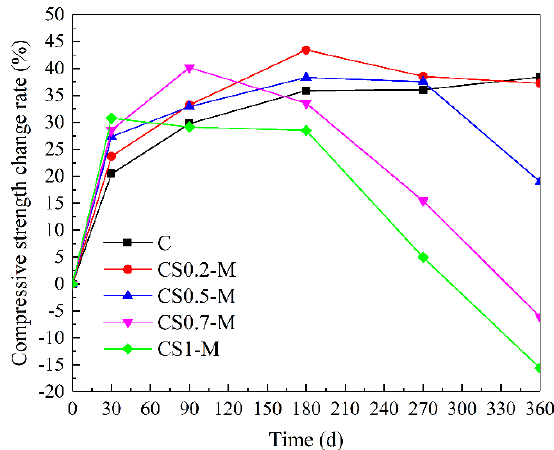
Figure 3. Compressive strength of concrete specimens against corrosion time. The change in damage appearance after erosion for 180 and 360 d from compressive strength tests of samples showed that the damage degree in solutions containing MgSO 4 was significantly higher than for samples in only NaCl solution (Figure 4). After 180 d of erosion, with increased MgSO 4 concentration, cracks on sample surfaces gradually widened and extended, shifting to the middle of samples. CS0.7-M had cracks that ran through each other and concurrent surface peeling. The mortar layer on the surface of CS1-M was severely peeled off and after 360 d of erosion, CS0.2-M showed severe peeling with intersecting cracks that penetrated each other. There are many vertical cracks on the surface of CS0.5-M and CS0.7-M, which exposed a large amount of coarse aggregate. The mortar layer on the surface of CS1-M was also severely peeled off, which showed that in NaCl-MgSO 4 solution, the damage degree in the appearance and morphology of concrete after compressive strength testing increased with increased MgSO 4 concentration and pro- longed erosion time. ( b ) Figure 4. Compressive strength destruction appearance; erosion for ( a ) 180 d and ( b ) 360 d. From the above analytical results, the change in compressive strength was clearly seen to be related to cement hydration, SO 42 − and Mg 2+ concentrations in the erosion solu- tion, and erosion time. As erosion time increases, the concrete structure at the eroded sur- face changes. Due to the complex physical–chemical reactions of Cl − , SO 42 − , and Mg 2+ with cement hydration products result in the deterioration of the concrete microstructure, which in turn affects the compressive strength and damage characteristics of the concrete. 3.2.2. Relative Dynamic Modulus of Elasticity Ultrasonic measurement of the DEM belongs to nondestructive testing, using ultra- sonic waves transmitted into the tested concrete and judging the internal damage degree according to the attenuation characteristics of ultrasonic waves in the process of propaga- tion through the object. According to Equation (3), the change trend of the relative DEM after different erosion regimes was calculated.